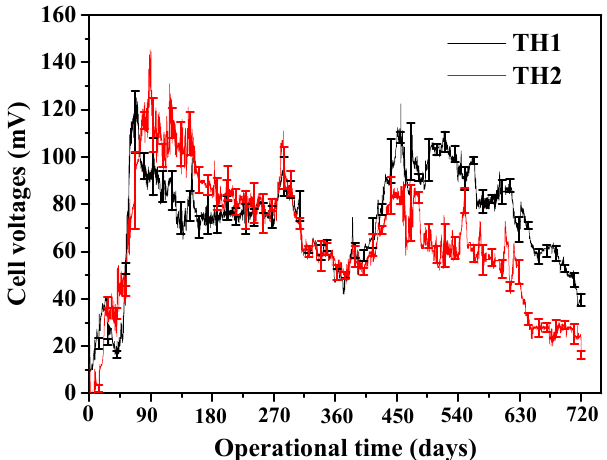
Figure 1. Voltage generation along with time from sediment microbial fuel cells (SMFCs) inoculated with TH1 and TH2 sedimentary samples. Voltages were represented as mean voltages and standard deviations (n = 2).